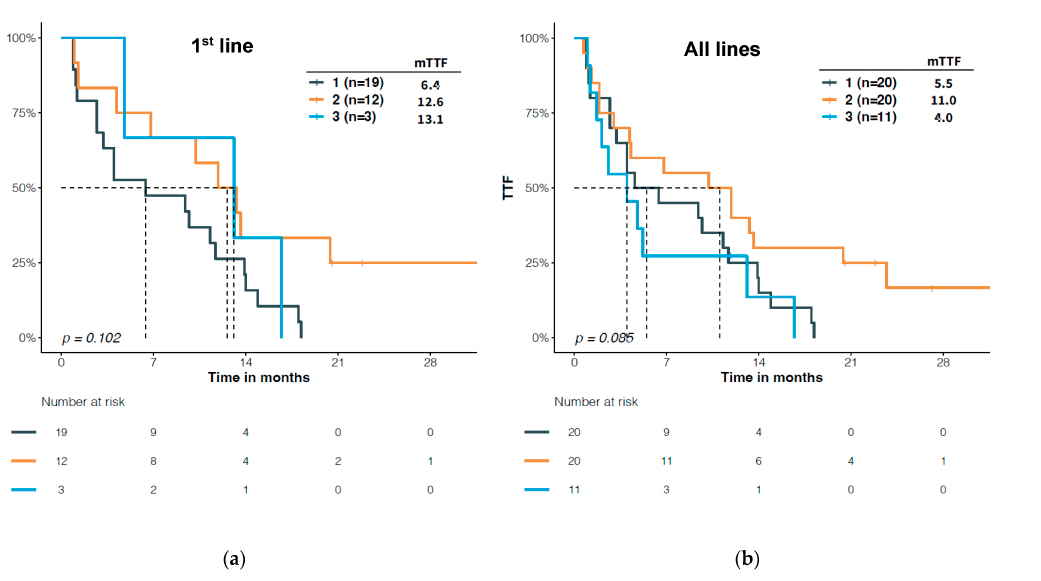
Figure 6. Differential time to treatment failure (TTF) in patients with atypical, classical-like EGFR mutations upon different generation EGFR TKIs. ( a ) 1st line treatment. ( b ) All lines.